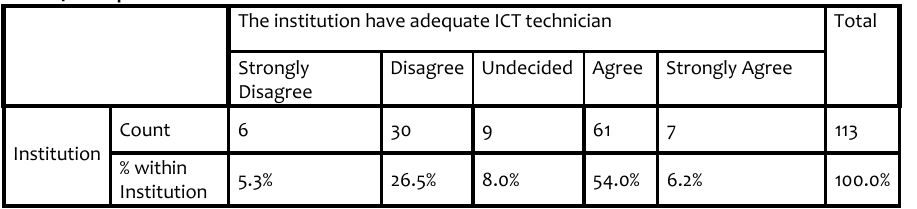
Table 4: Adequate ICT technician